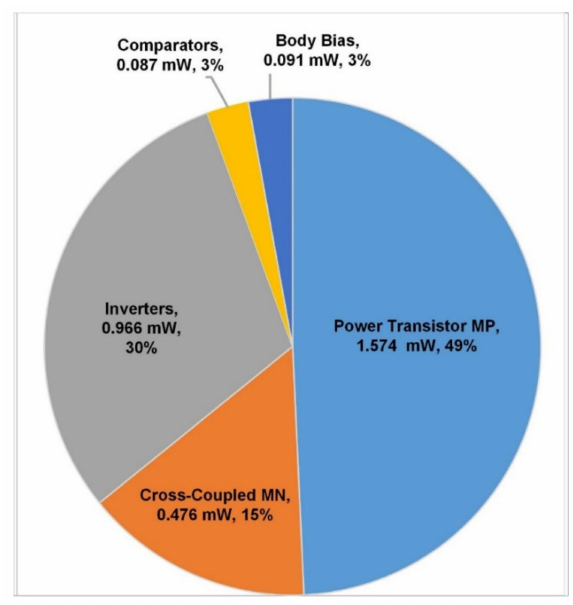
Figure 8. Pie chart of power